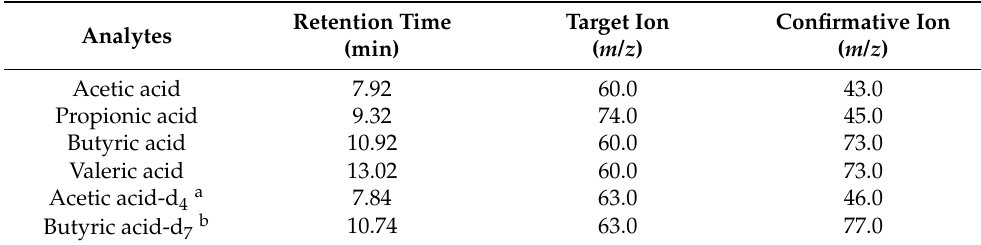
Table 1. Retention time and target m / z values of the SCFAs and internal